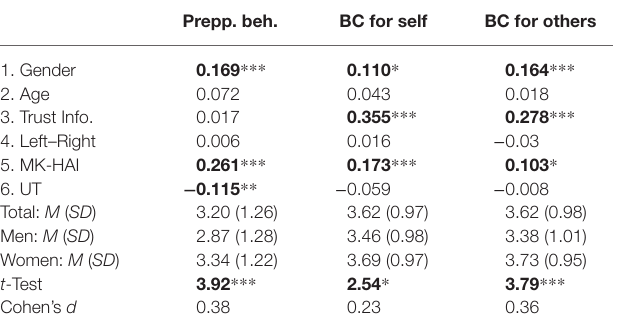
TABLE 8 | Means, SDs, and correlations for gender, age, trust in official information, political orientation, and health anxiety with self-centered prepping behavior, behavior change to avoid infection and behavior change in order to not infect others in Study 3. Prepp.